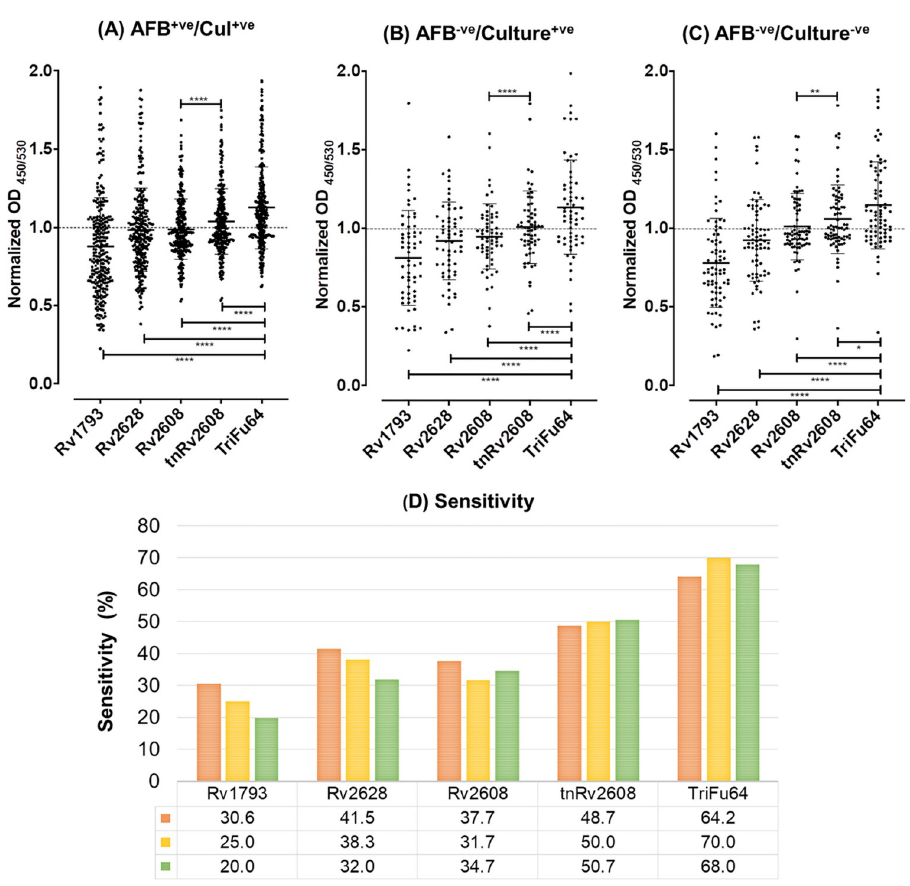
Fig 6. Comparison of sero-reactivity of TB patient groups separated by smear (AFB) and culture positivity. Scatter plot of normalized OD 450/630 values showing plasma sero-reactivity of AFB positive/Culture positive (A), AFB negative/Culture positive (B), AFB negative/Culture negative (C). The sensitivity of each antigen for each group is also shown (D). One way ANOVA with Dunn’s multiple comparison test ���� P < 0.0001, �� P < 0.005, � P < 0.05.